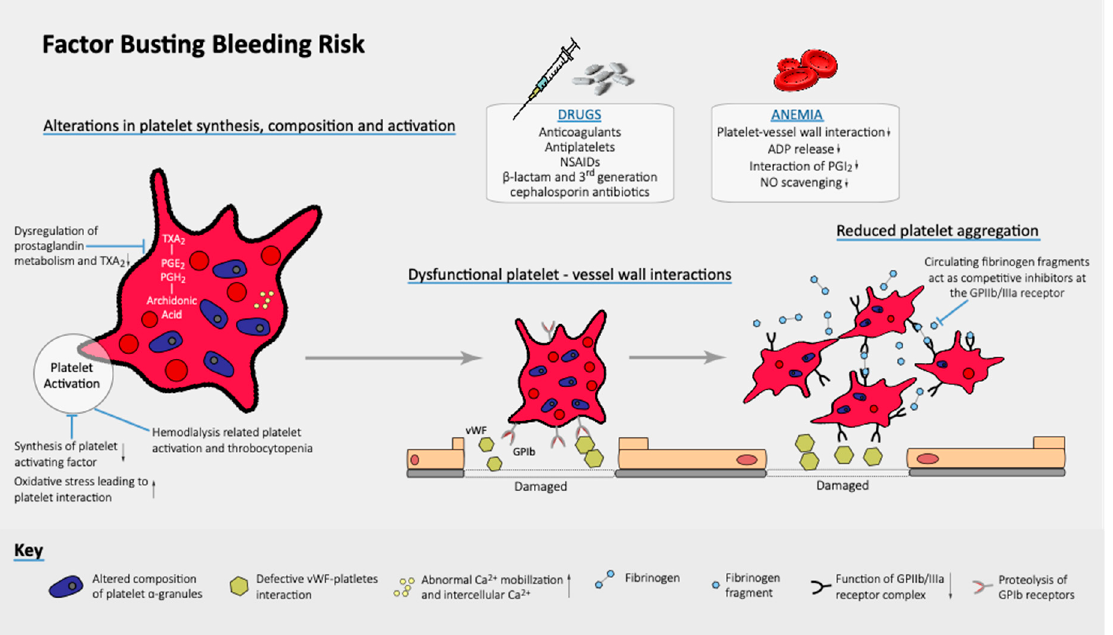
Figure 3. Factors contributing to pro-hemorrhagic state in CKD